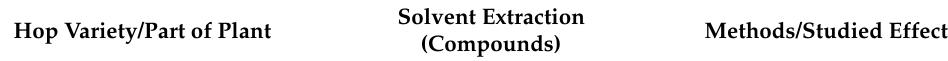
Table 3. Antimicrobial activities of hop